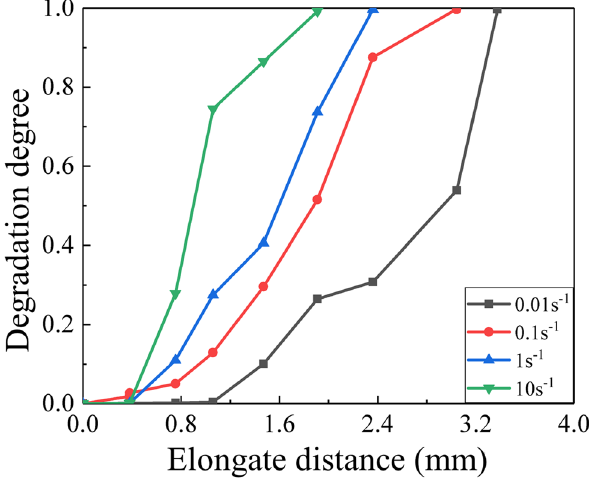
Figure 13: The damage degradation curves of Ti – 3Al – 2Mo – 2Zr alloy at di ff erent strain